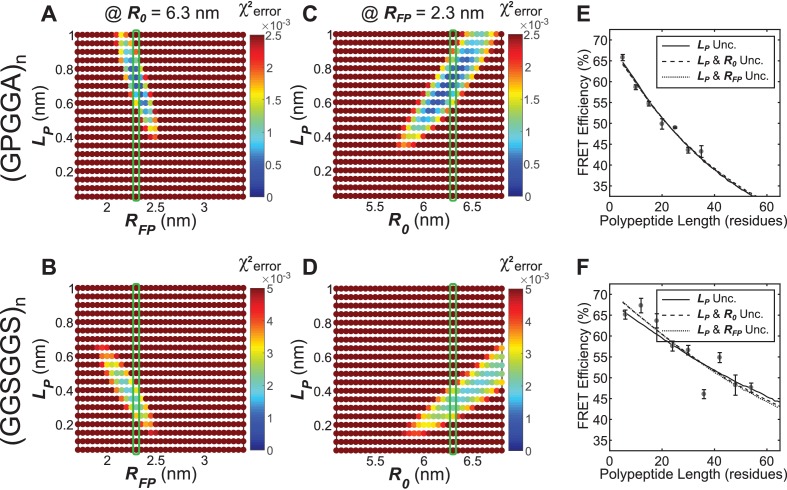
Parameter constraint has minimal effects on measurement of polypeptide persistence length (LP) in vitro.(A, B) Heatmaps of chi-squared error of model fits to in vitro ‘minimal’ Clover-mRuby2 based TSMod FRET-length measurements for various RFP and LP for (GPGGA)n (A) and (GGSGGS)n (B) extensible domains; literature estimate of RFP used for parameter constraint highlighted with green bar; R0 is constrained to 6.3 nm. (C, D) As in panels (A and B), except various R0 and LP parameters were examined; green bar highlights R0 parameter estimate; RFP is constrained to 2.3 nm. (E, F) Model fits to in vitro FRET-length relationships for ‘minimal’ Clover-mRuby2 based TSMods containing the (GPGGA)n (E) or (GGSGGS)n (F) extensible domain are equally accurate with either a single unconstrained (unc.) parameter (LP) or two unconstrained parameters.